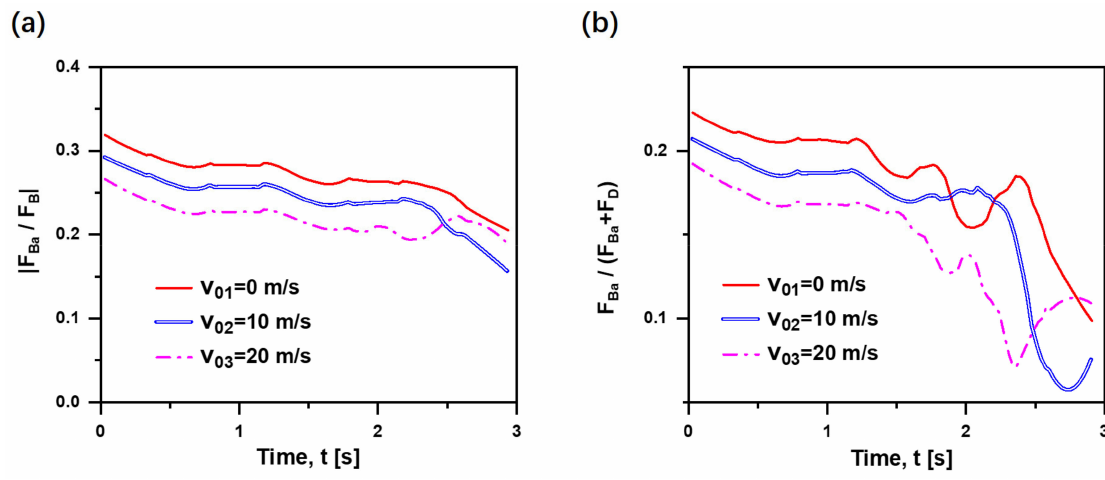
→ → → → → F Ba / F B | ; ( b ) F Ba / ( F D + F Ba ) over time at three initial velocities ( d b = 1 mm,